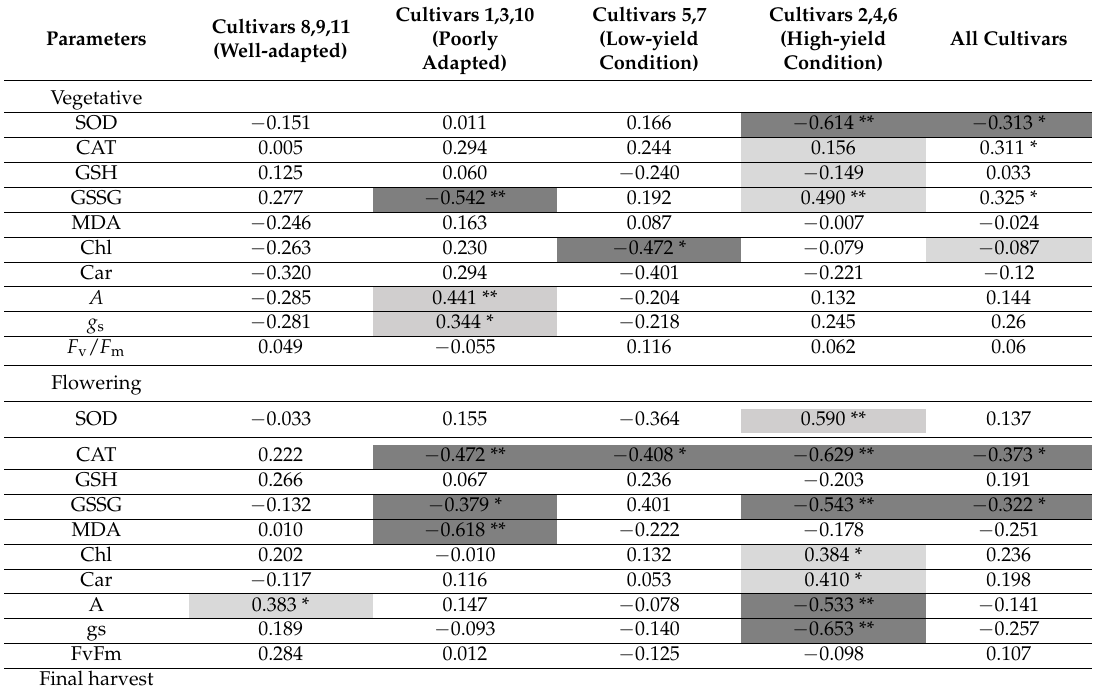
Table 2. Correlation of the different parameters with the grain yield plant − 1 for the groups assigned from the Finlay method. Significant correlations are in bold. Positive correlations (light grey) and negative (grey) are presented in the table. Superoxide dismutase activity (SOD), catalase activity (CAT), reduced glutathione (GSH), oxidised glutathione (GSSG), malondialdehyde content (MDA), chlorophyll (chl), carotenoid (Caro), photosynthesis ( A ), stomatal conductance ( g s ), ratio of variable to maximal chlorophyll fluorescence ( F v / F m ), harvest index (HI), 1000 grain weight plant − 1 (1000_grain wt), inflorescence weight plant (Inflorescence wt) and